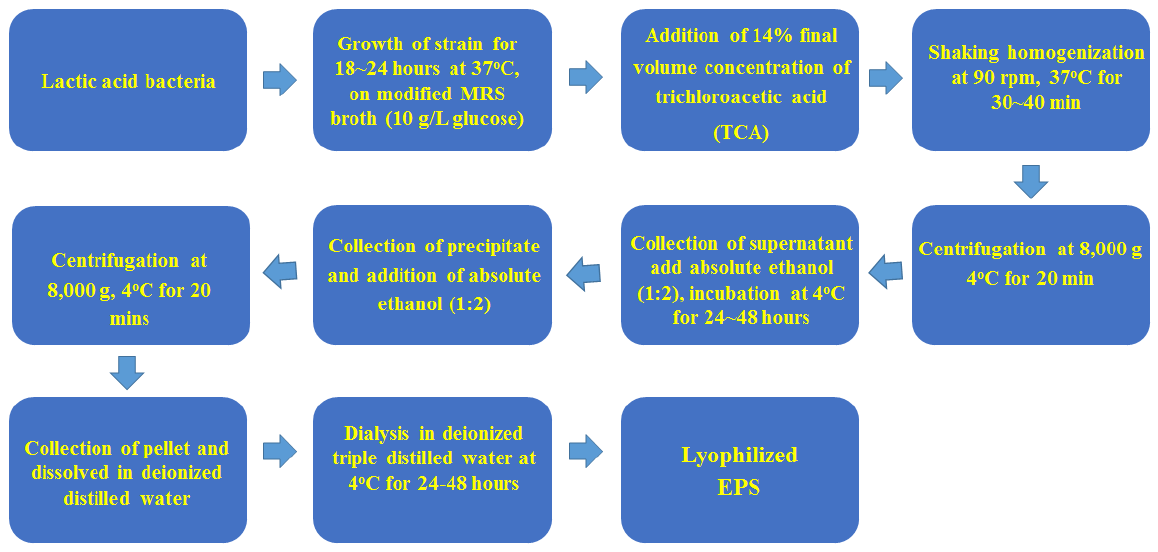
Figure 1: Flow chart of partial purification of functional exopolysaccharide